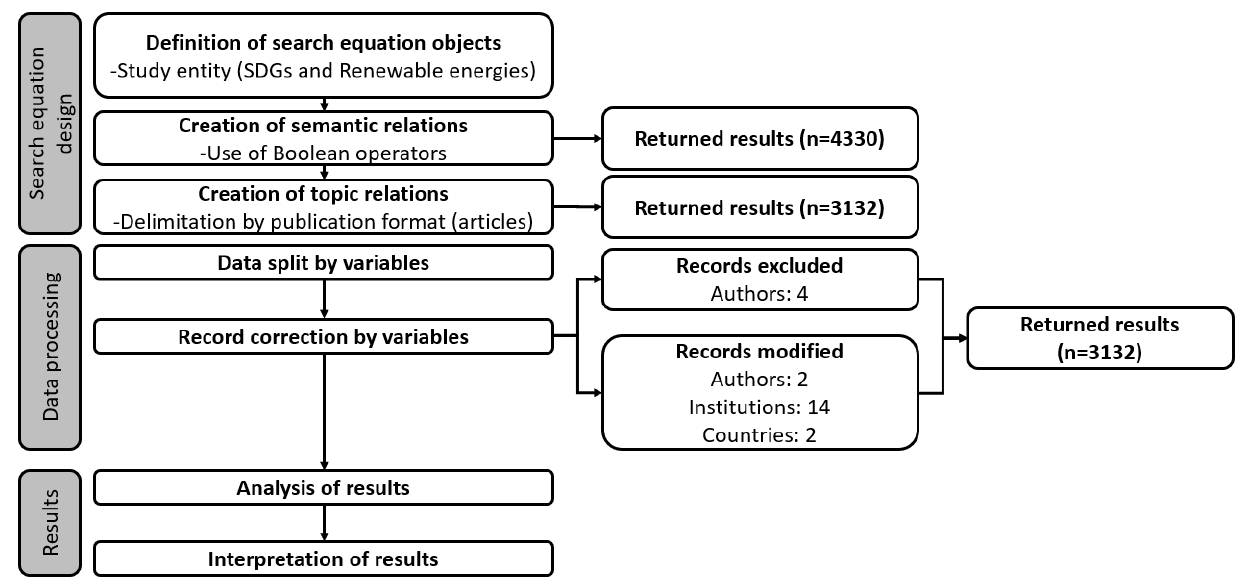
Figure 1. Flow diagram about the bibliometric review procedure developed. Source: own elaboration based on PRISMA guidelines.